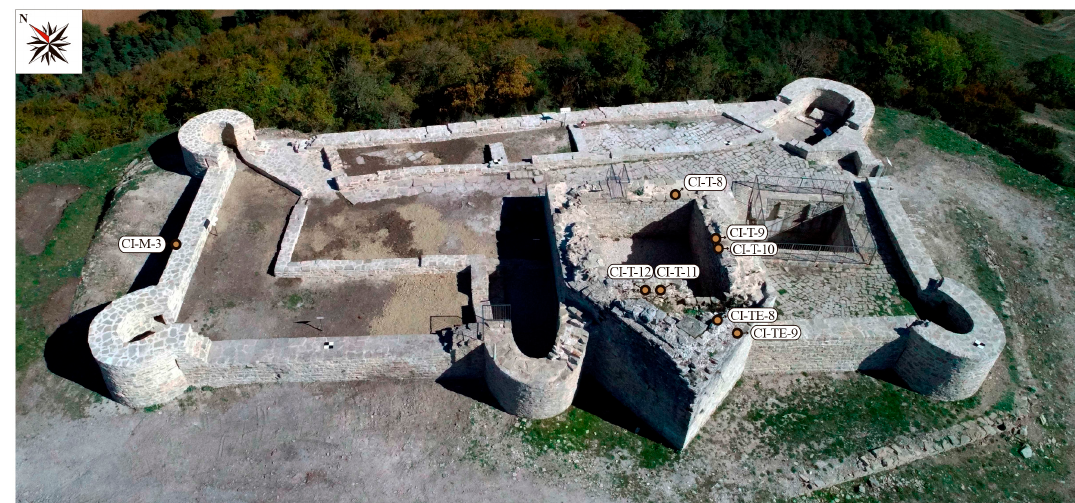
Figure 2. Location of studied samples in the Tower Keep and West perimeter wall at Irulegi Castle.